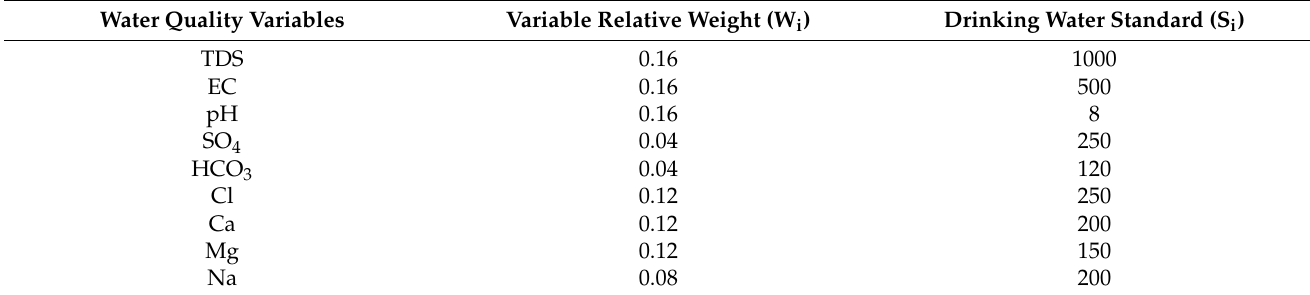
Table 2. Relative weights and water quality standards of the water quality